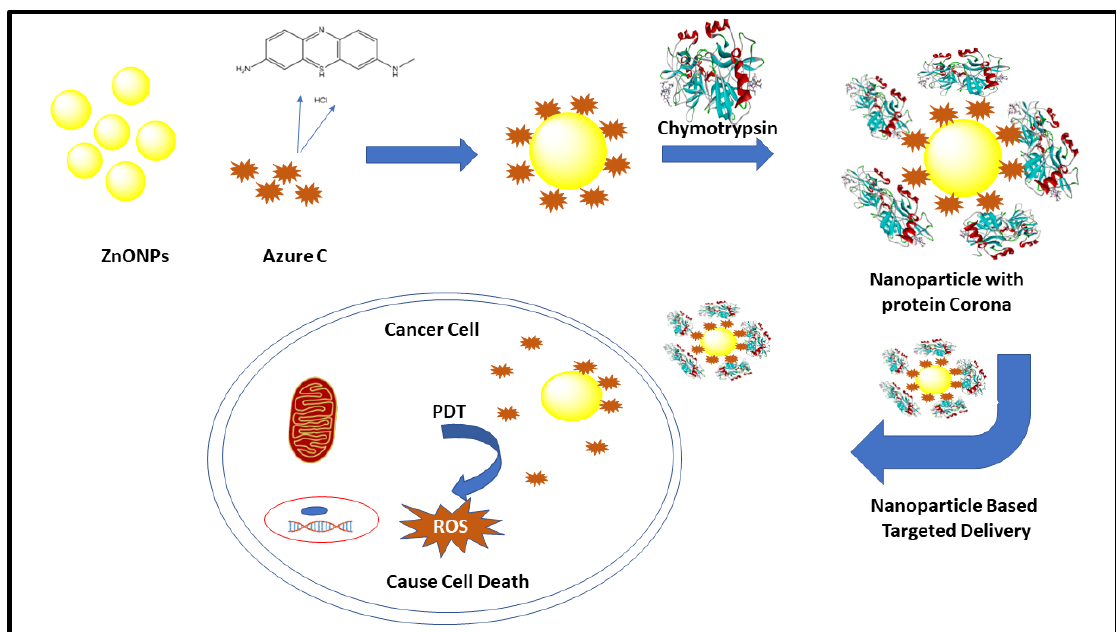
Figure 9. Biological relevance of nanoparticle ‐ based targeted delivery against cancer.